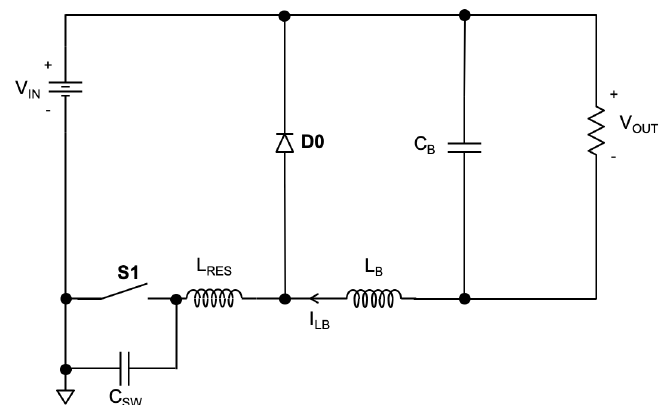
Figure 4. Floating Buck ZVS-QRC Circuit Diagram.